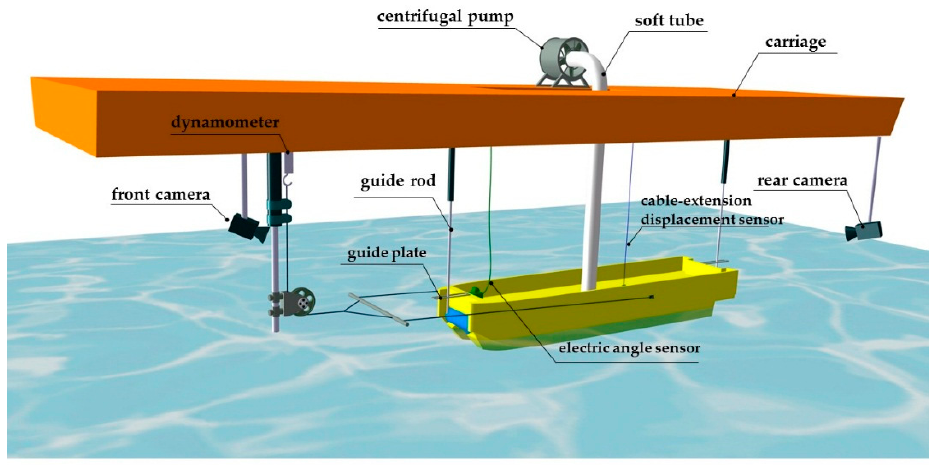
Figure 5. Sketch of experimental setup.